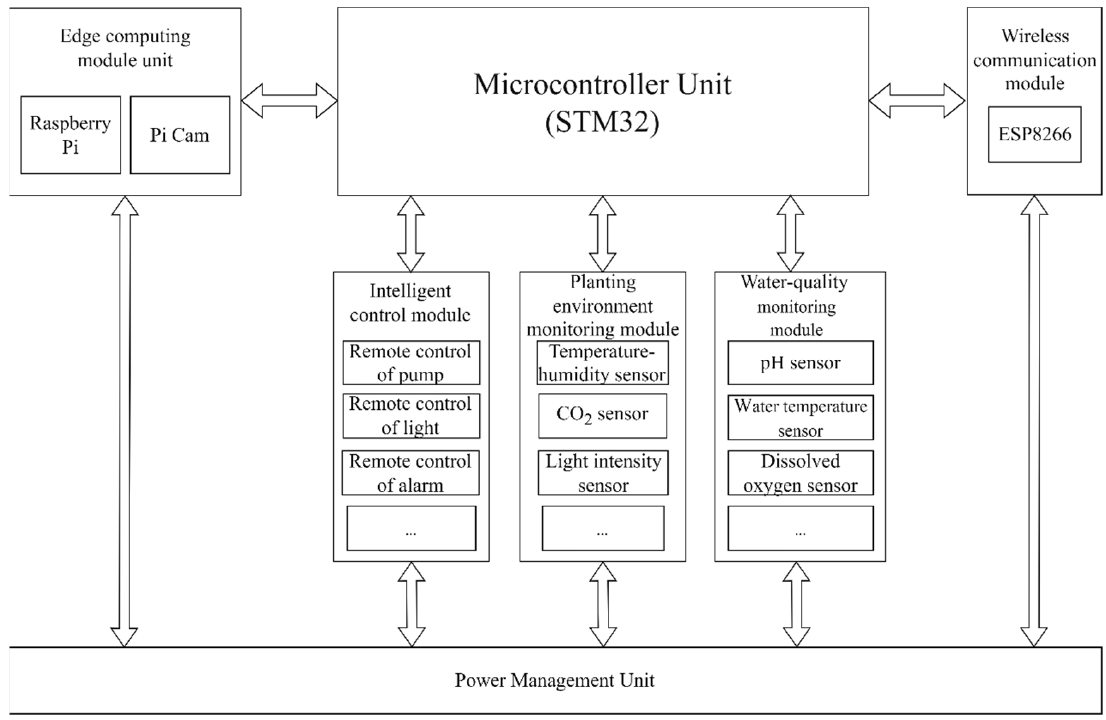
Figure 2. The general framework of the hardware.